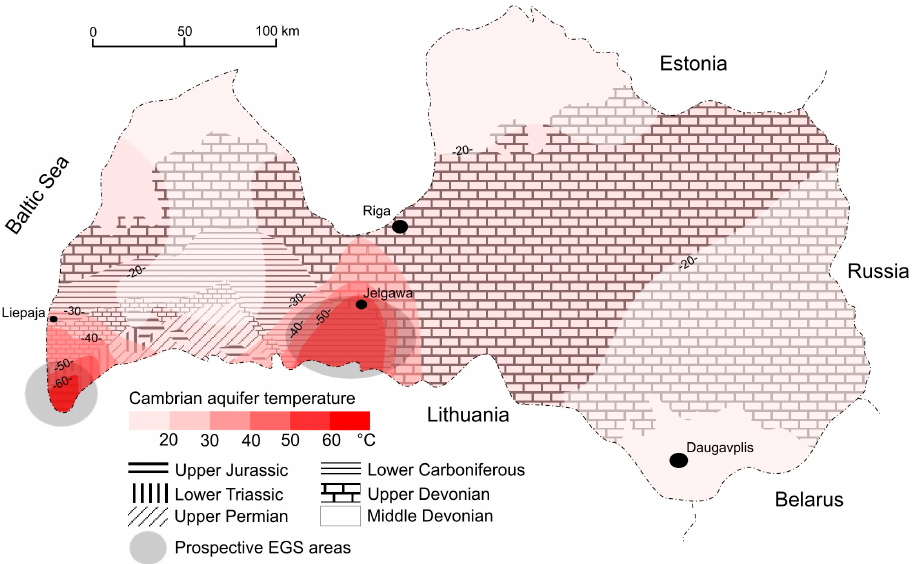
Figure 5. Average temperature in Cambrian underground water horizon, on the background of the geological setting of Latvia (based on [44,45] ).